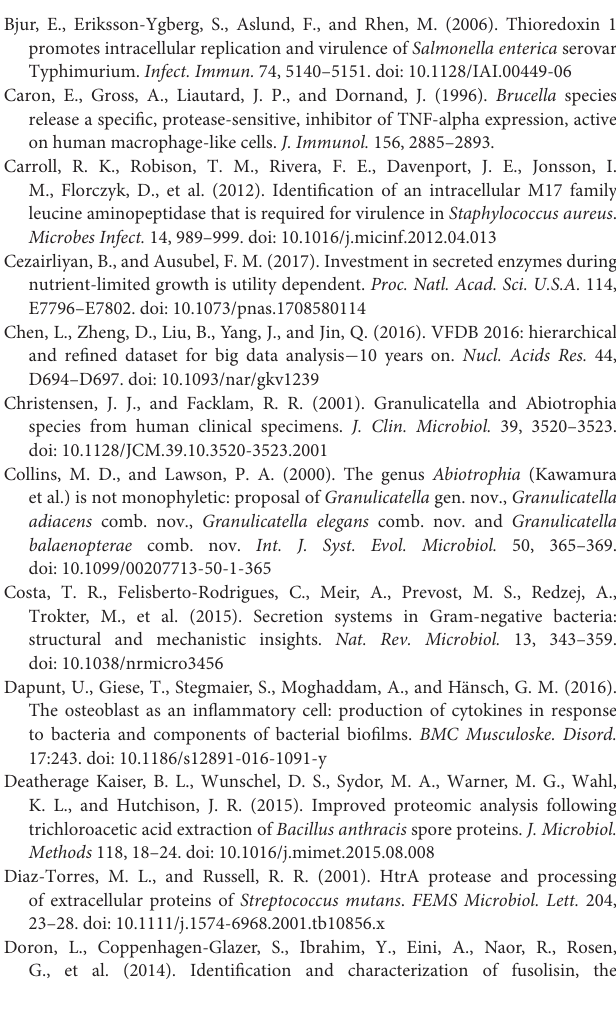
Table S1 | List of proteins identified in G. adiacens secretome. Secretome preparation from G. adiacens was analyzed by LC-MS/MS and further revealed by database search